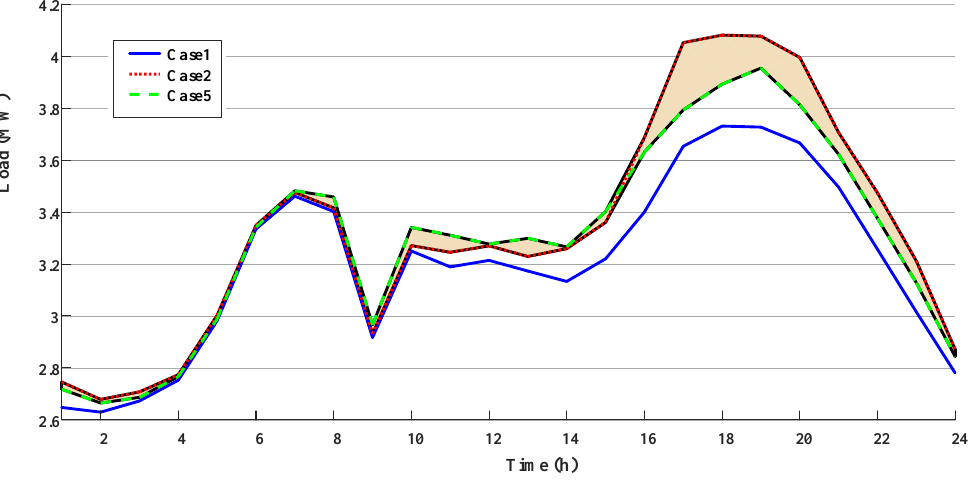
Table 9. Peak and valley load values in different cases.